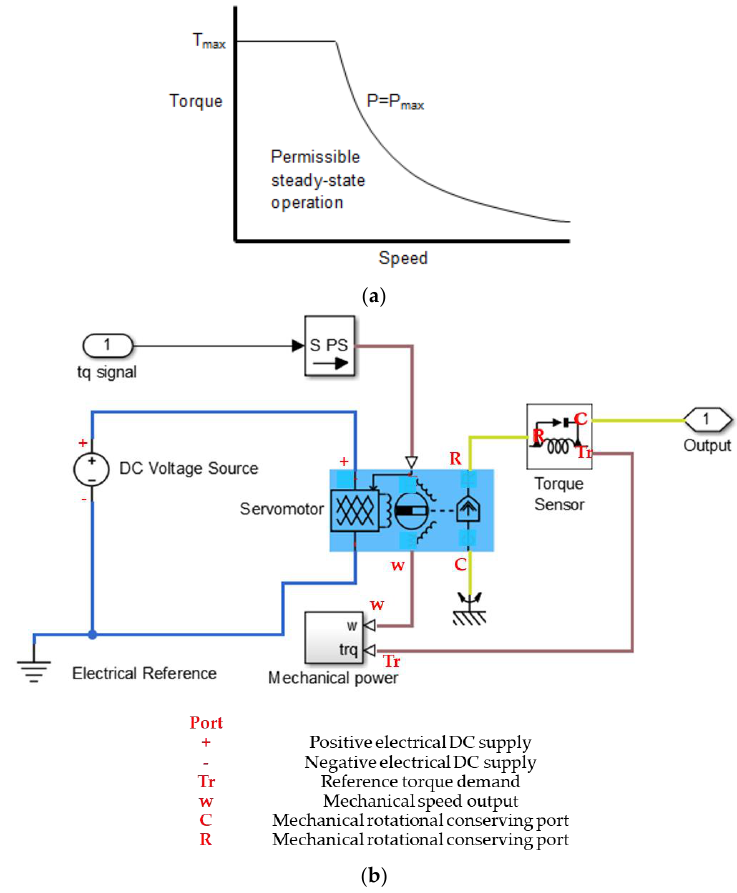
Figure 8. ( a ) Torque – speed envelope in motor model. ( b ) EM system model.